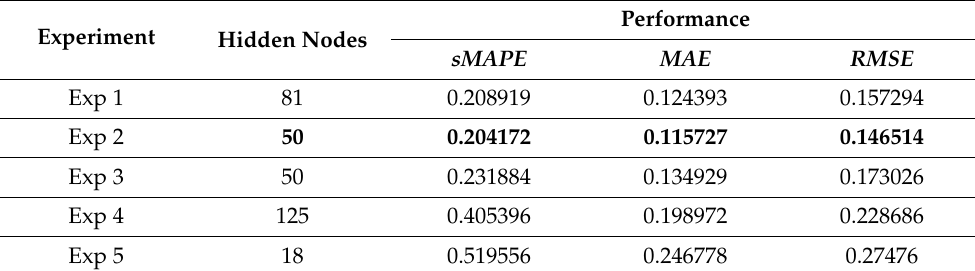
Table 1. OP-ELM experiments